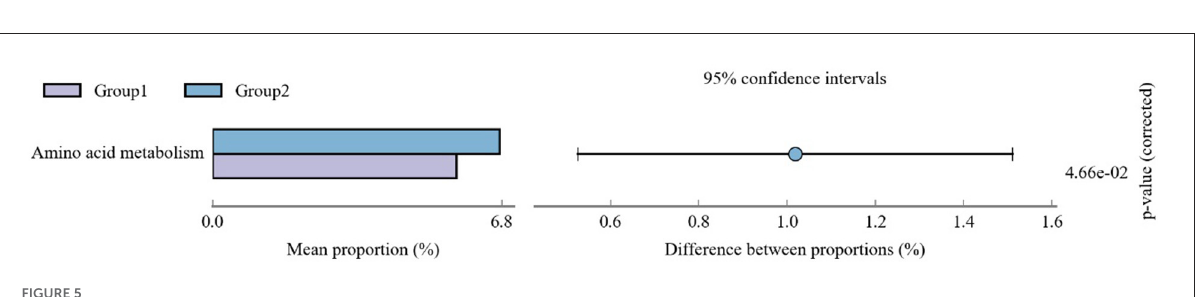
FIGURE5 Differences between metabolic